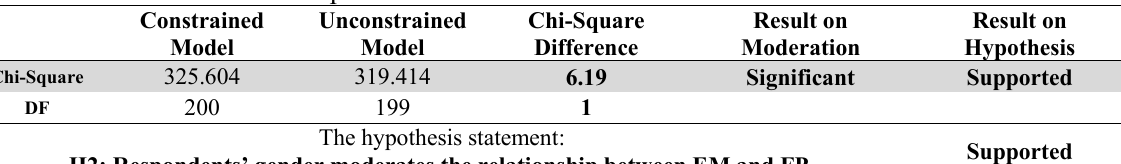
Moderation Test for Male Group Data